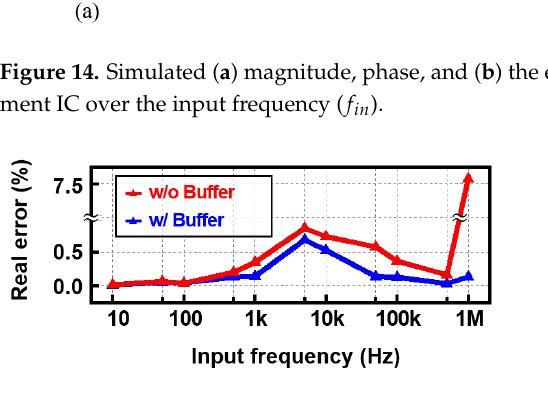
Figure 15. Simulated real error with and without the buffer over the input frequency ( f in